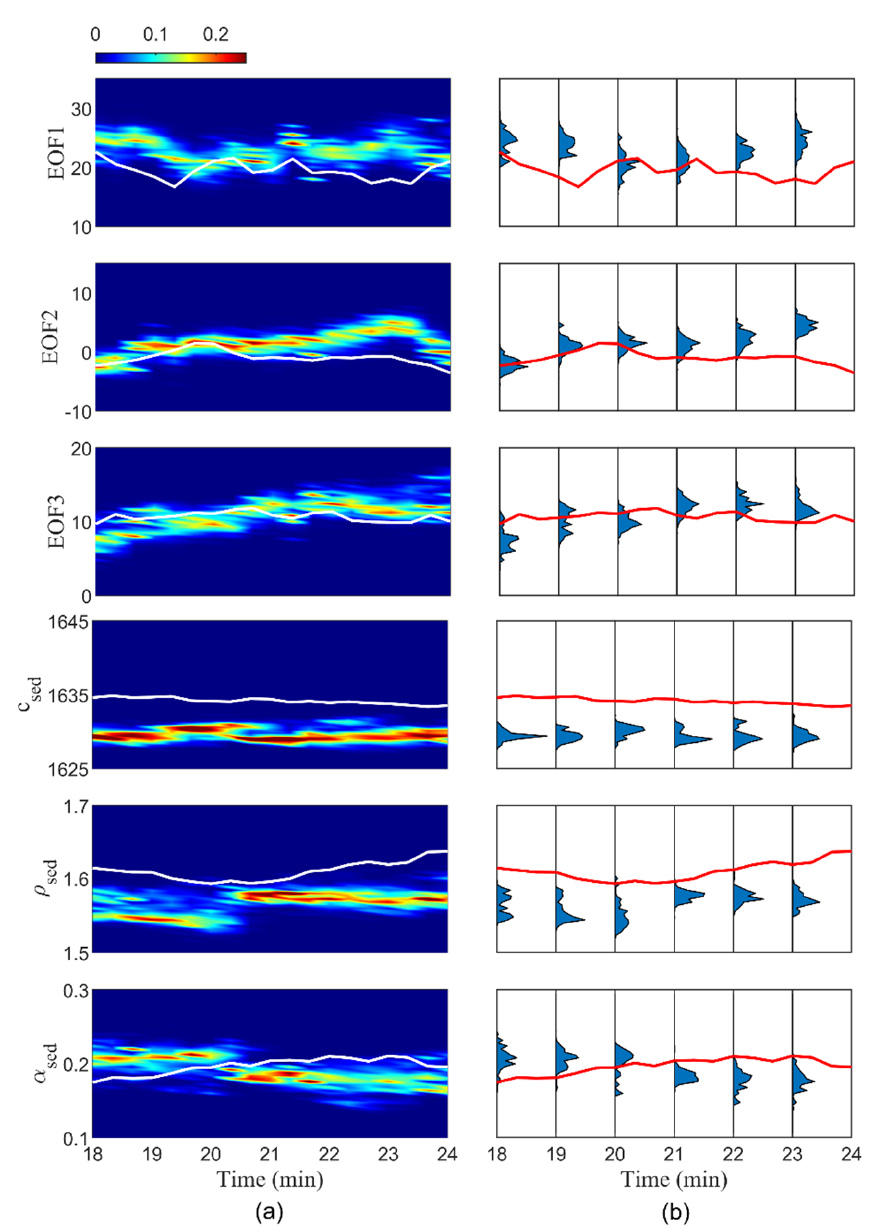
Figure 5. PF results: ( a ) variation in marginal PPDs for three EOFs and sediment parameters from 18 to 24 min, ( b ) vertical slices of the PPDs are given at every 1 min interval. Solid lines represent the true values.